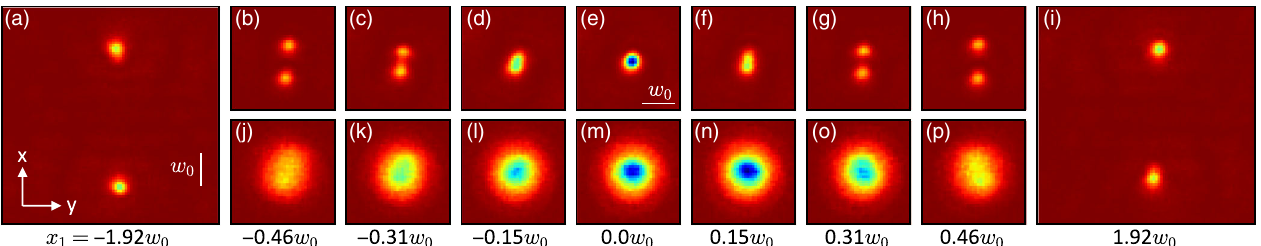
FIG. 4. Superradiant emission into the cavity supermode above the self-organization threshold for the data similar to that shown in Fig. 2(b). (a) – (i) Spatial structure of superradiant emission into the modes of a near-confocal cavity ( δ L ¼ 0 μ m) as the BEC is translated from x 1 ¼ − 1 . 92 w 0 to 1 . 92 w 0 . The two peaks merge at the center of the cavity, yielding a spot size smaller than the TEM 0 ; 0 mode waist. Images (j) – (p) show superradiant emission for BECs in a single-mode cavity. The BECs are in the same locations as in the above panels. The cavity is set to δ L ¼ 65 . 1 μ m, ϵ ≈ 60 MHz, to achieve near-single-mode operation. We see that the profiles are close to the width and shape of a TEM 0 mode. All images are plotted with identical length scales, including panels (a) and (i), which have ; 0 ¼ 20 MHz. The white bars in (a) and (e) represent the length of larger fields of view. Data are taken at a pump-cavity detuning of Δ 0 ; 0 the waist of the TEM 0 mode. ; 0